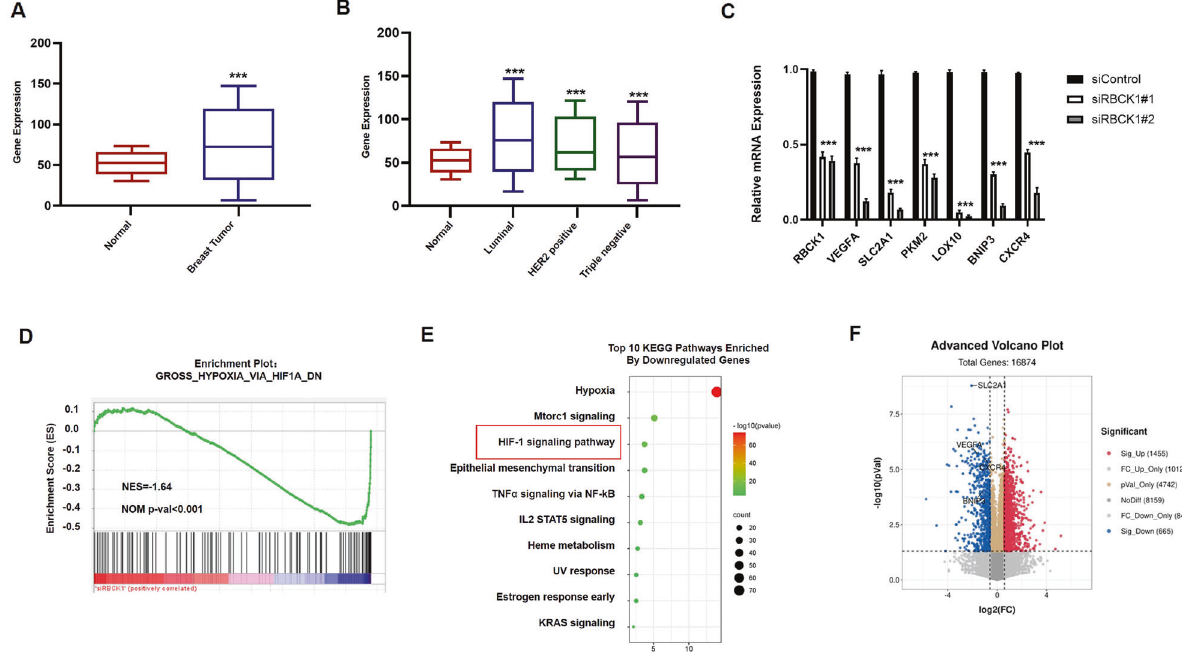
Fig. 4 Bioinformatic analysis reveals the correlation between RBCK1 and HIF1 α signaling in ER-positive breast cancer cells. A , B Publicly available data shows that RBCK1 is signi fi cantly highly expressed in ER-positive breast cancer. (http://oncomine.org). C – E Gene Set Enrichment Analysis and KEGG map of RNA sequencing data display that the silence of RBCK1 in MCF-7 inhibits HIF1 α signaling pathway. MCF-7 cells were transfected with siRBCK1 or siControl. After 36 h, the cells were treated with hypoxia for 12 h, then the total mRNA of the two groups of cells was extracted for real-time PCR technology and RNA sequencing analysis. The siControl and siRBCK1 groups were analyzed more than three times. F Volcano map shows that after RBCK1 level is knocked down in MCF-7, the mRNA levels of HIF1 α target genes VEGFA, SLC2A1, and BNIP3 are reduced.